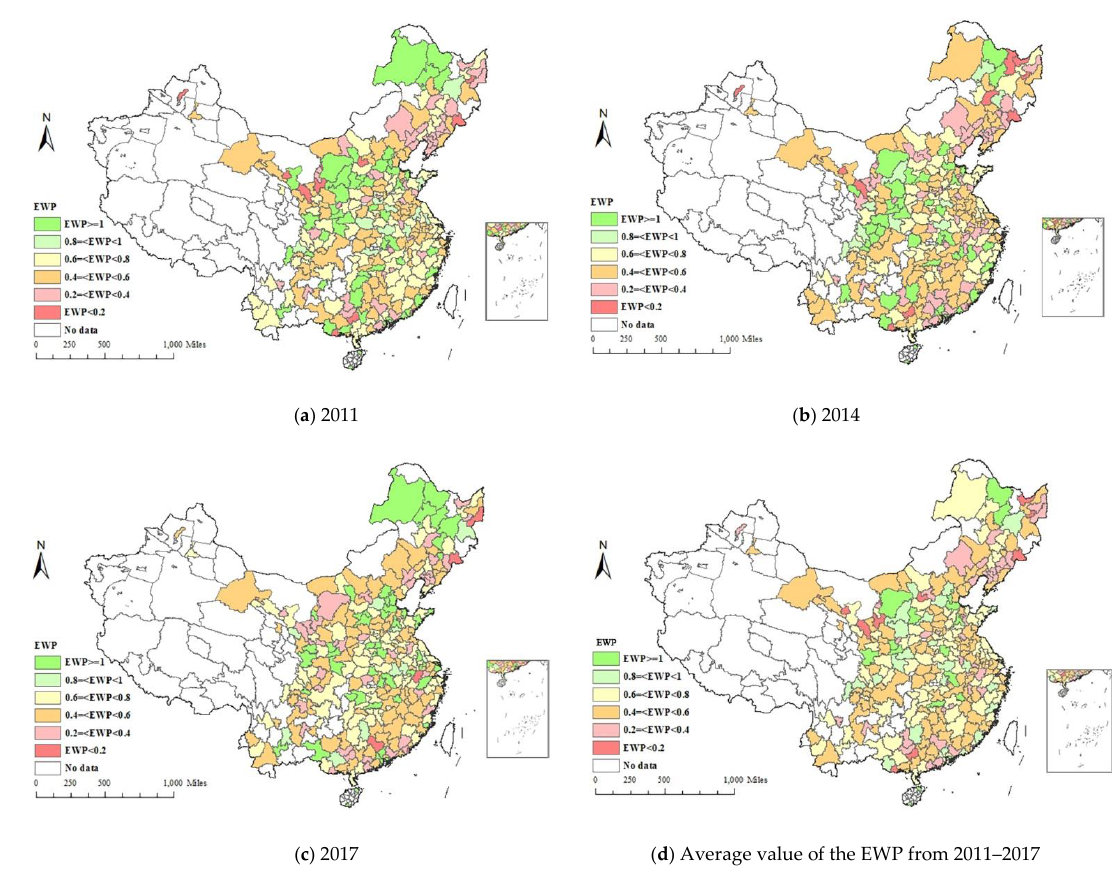
Figure 5. Spatial pattern of the urban EWP in 2011, 2014, 2017 and